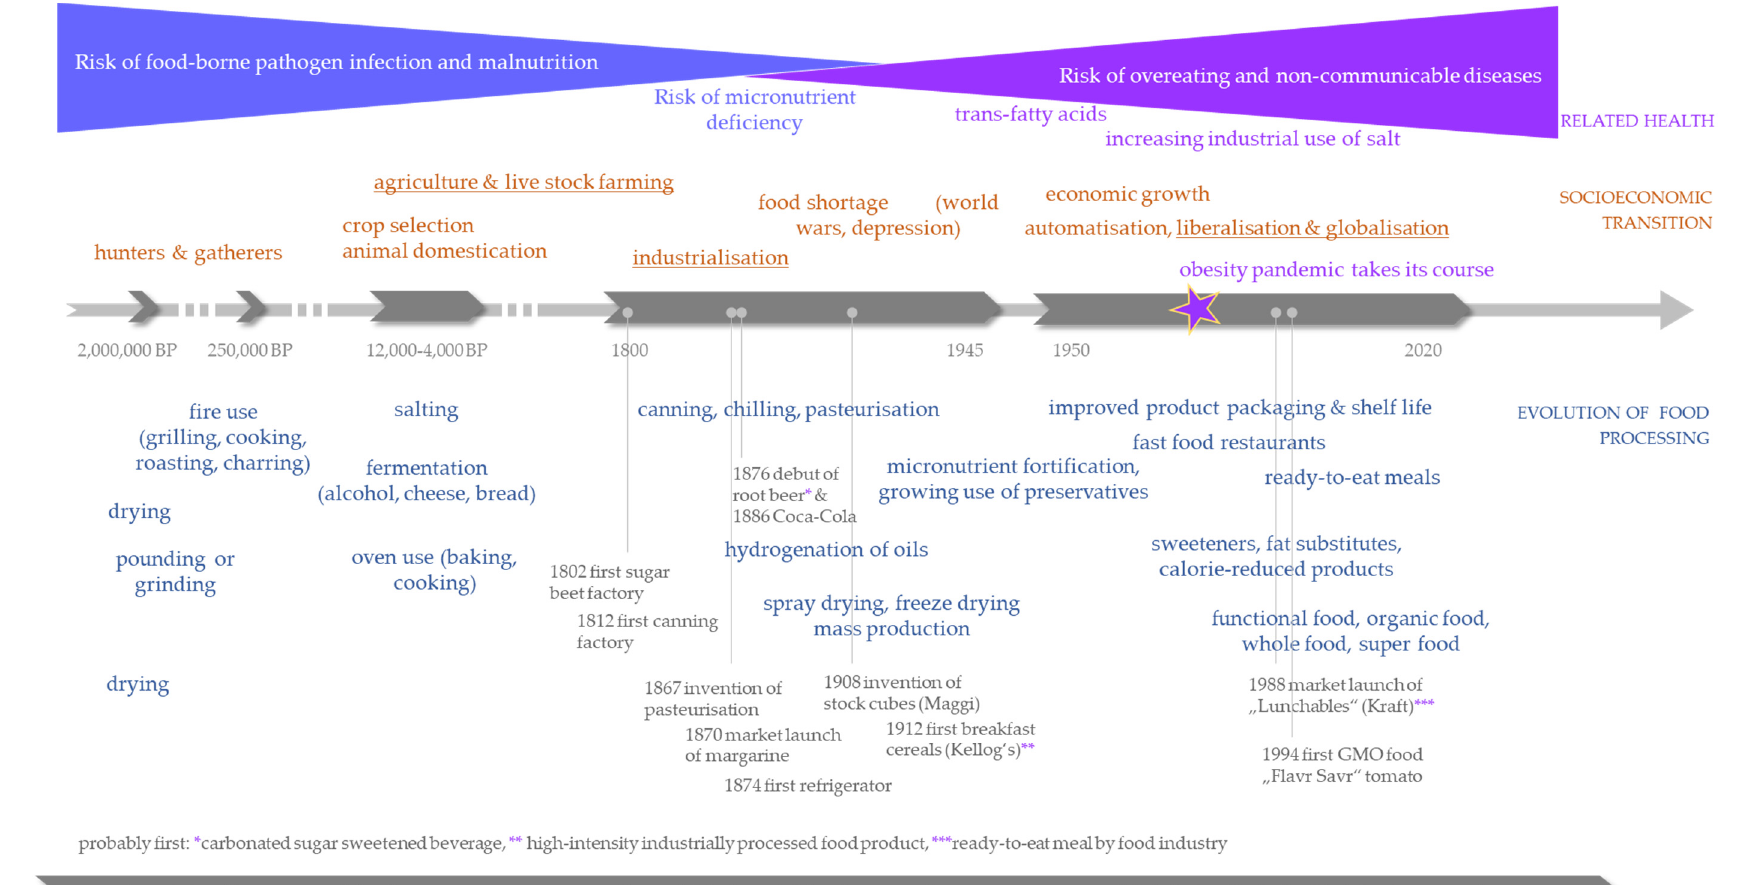
Figure 1. Time-dependent evolution of food processing associated with major transitions in human socioeconomic conditions.